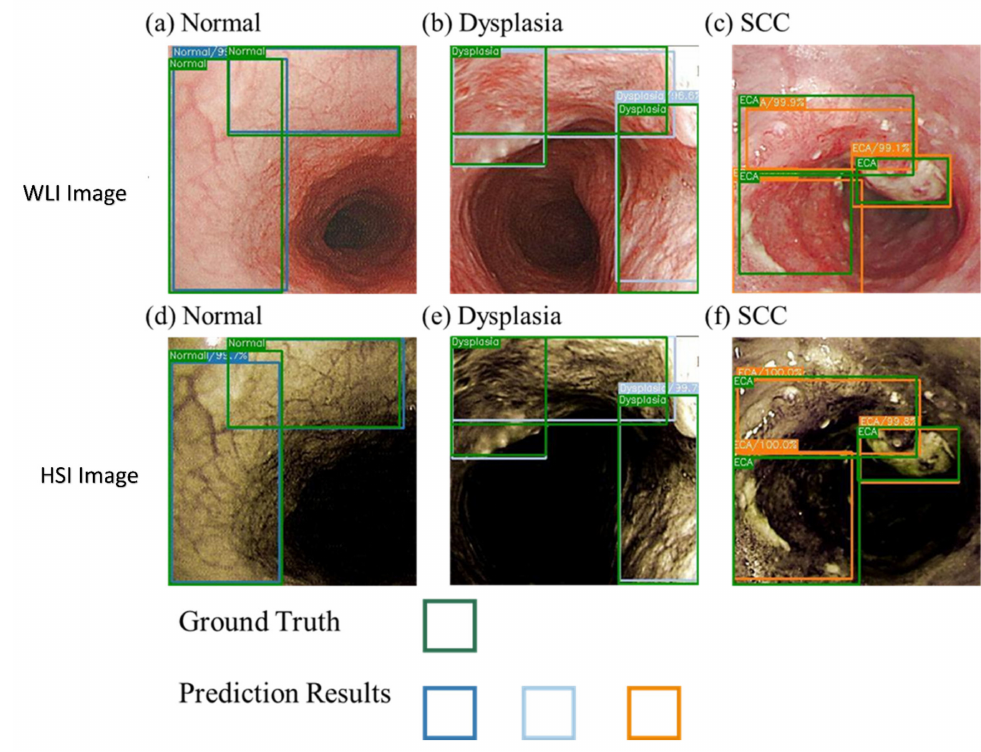
Figure 4. Comparison of the WLI and the HSI